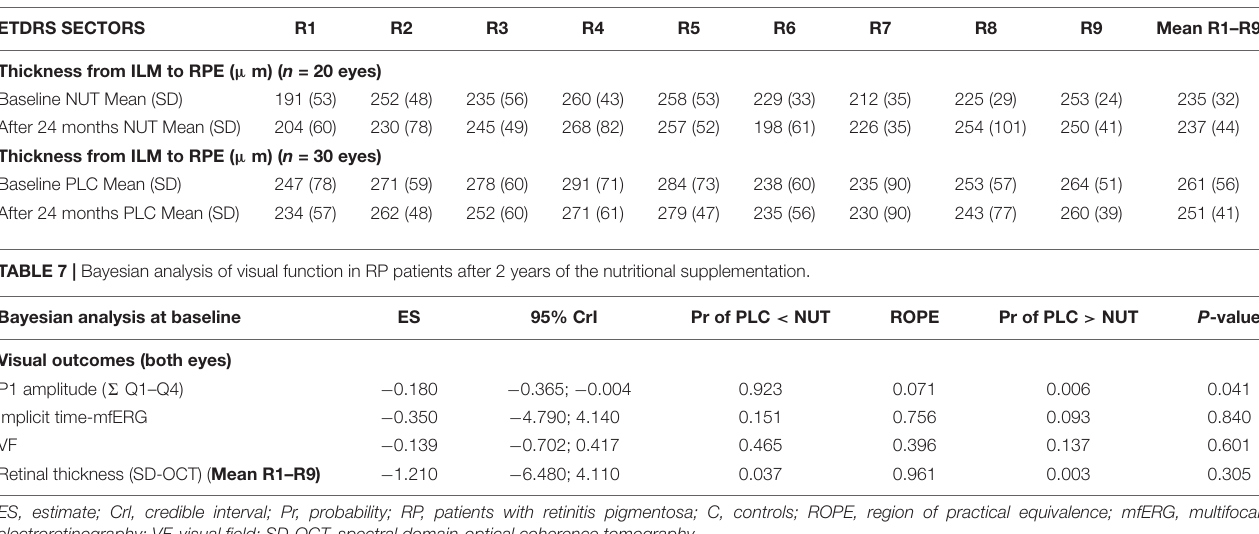
TABLE 6 | Early Treatment Diabetic Retinopathy Study sector map of macula using CIRRUS software (SD-OCT) at baseline and 24 months after nutritional supplementation. ETDRS SECTORS R1